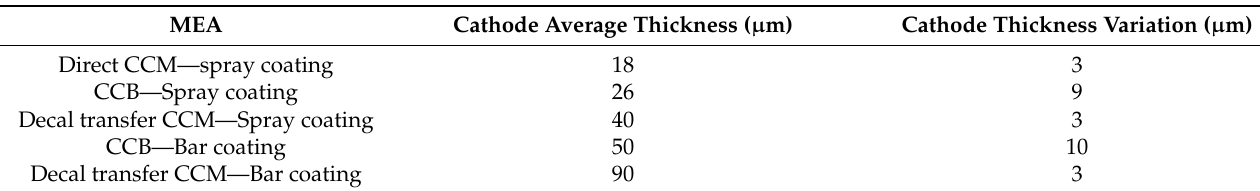
Table 2. Thickness of cathode catalyst layer.